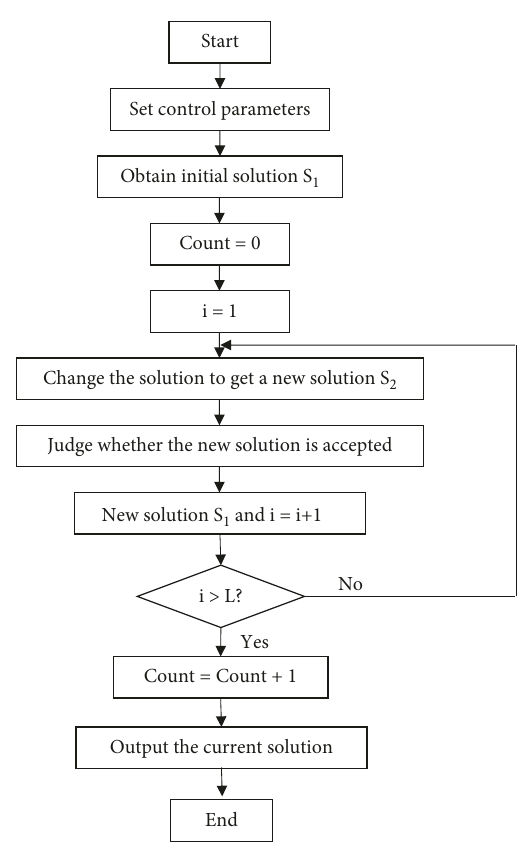
Figure 6: Solution process of the simulated annealing